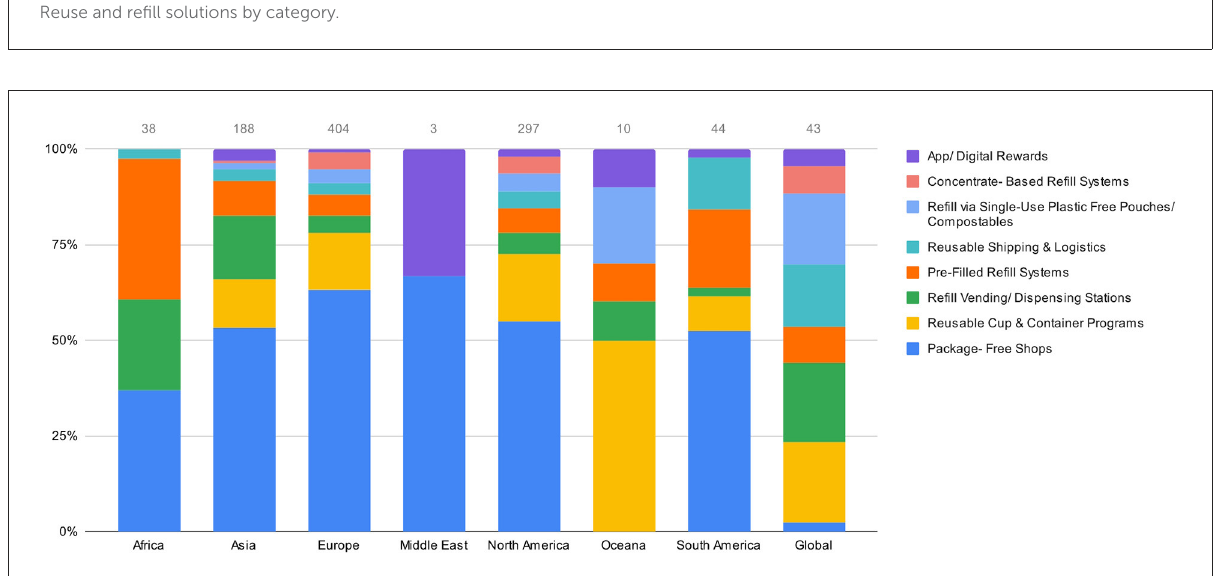
FIGURE3 Reuse and refill solutions by type and active